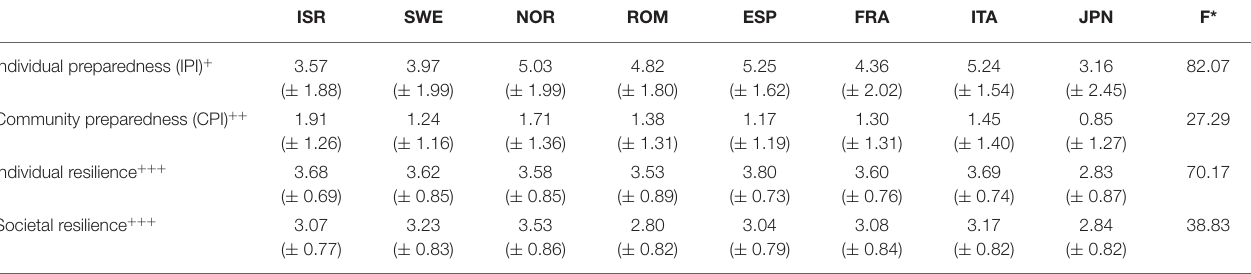
TABLE 4 | Comparison of mean scores to primary outcomes between countries ( N =